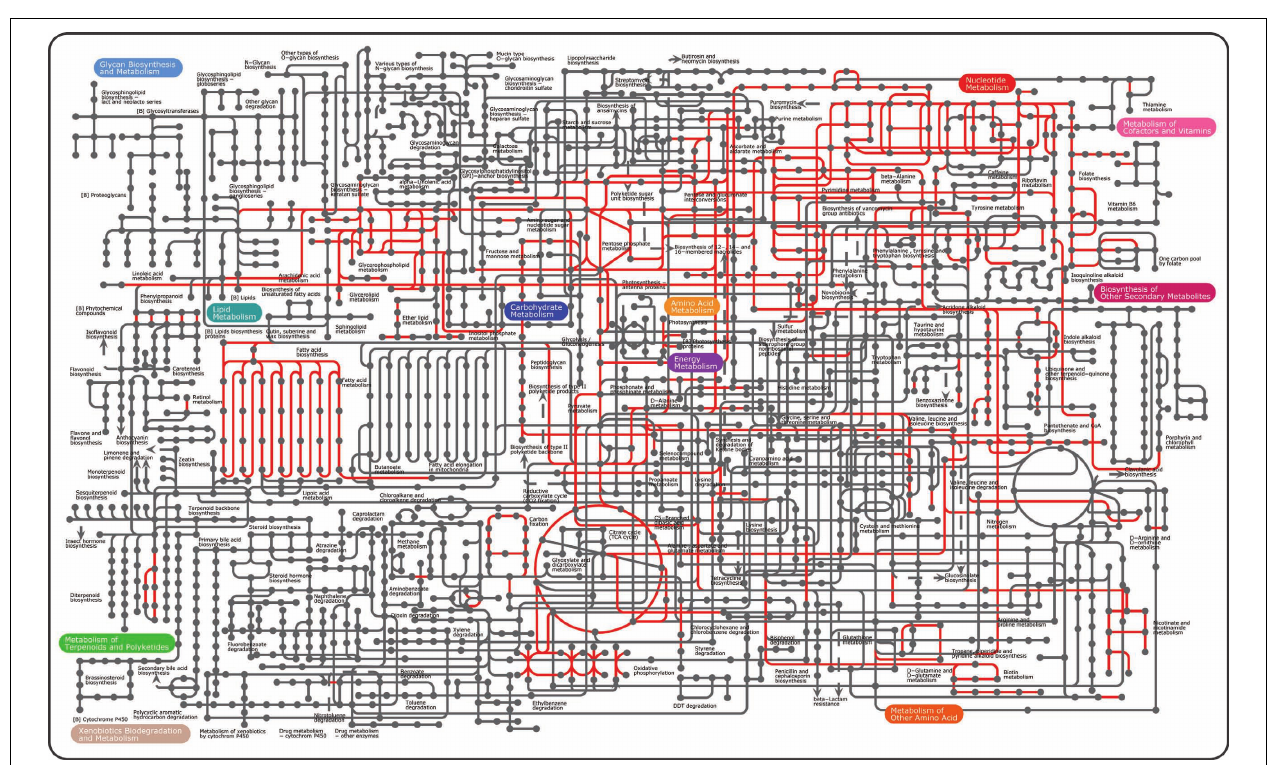
FIGURE 1 | Overview of the microbial pathways on the KEGG pathways using the iPath tool (Letunic etal., 2008). To date, conserved pathways known as essential are shown in red. Hypothetical proteins found as essential are